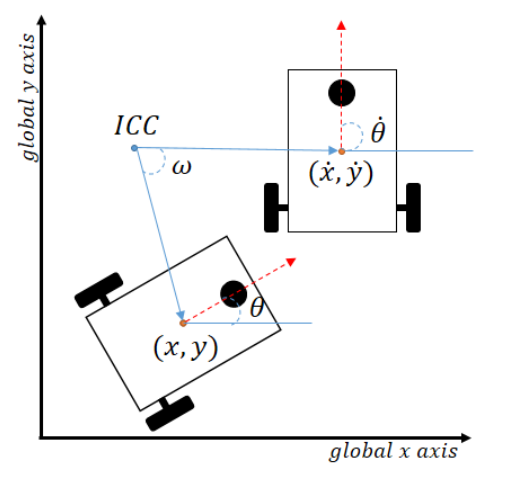
Figure 2. Dynamic model of a two-wheeled differential